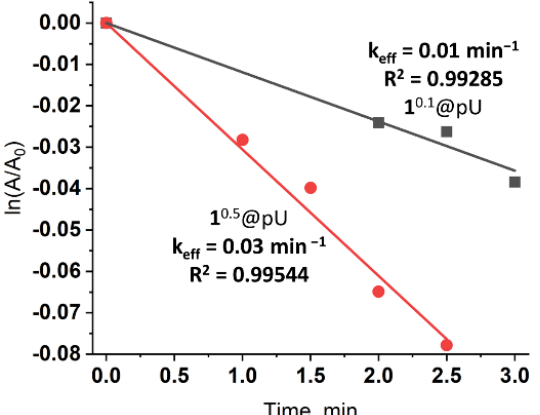
Figure 4. ln(I/I 0 ) vs. time plots for the reaction of DHN (0.1 mM) transformation in the presence (0.05 mg mL − 1 ) of 1 0.1 @pU (grey squares) and 1 0.5 @pU (red circles) in water (20 mL). The line of the corresponding color represents linear approximation.